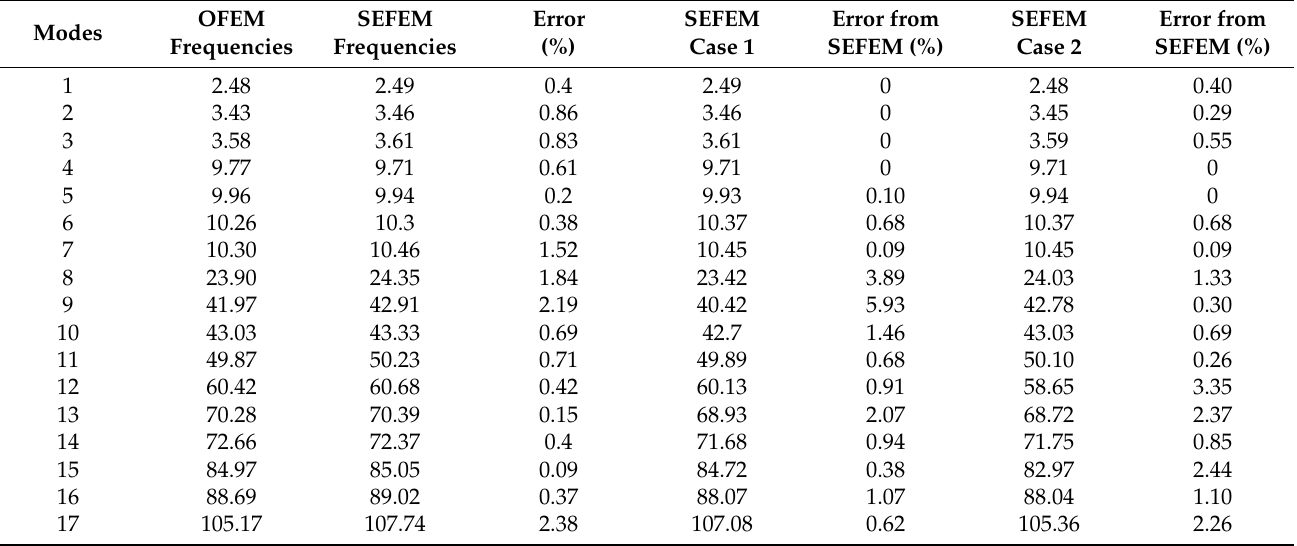
Table 2. Comparison of the vehicle natural frequencies (Hz).